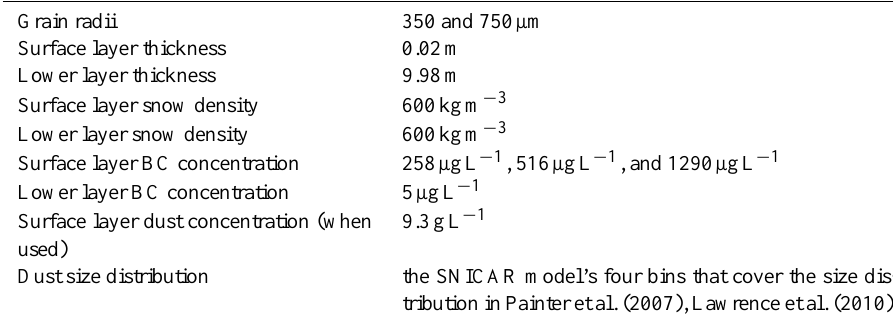
Table 2. Input field values used to estimate spectral snow albedo in SNICAR.